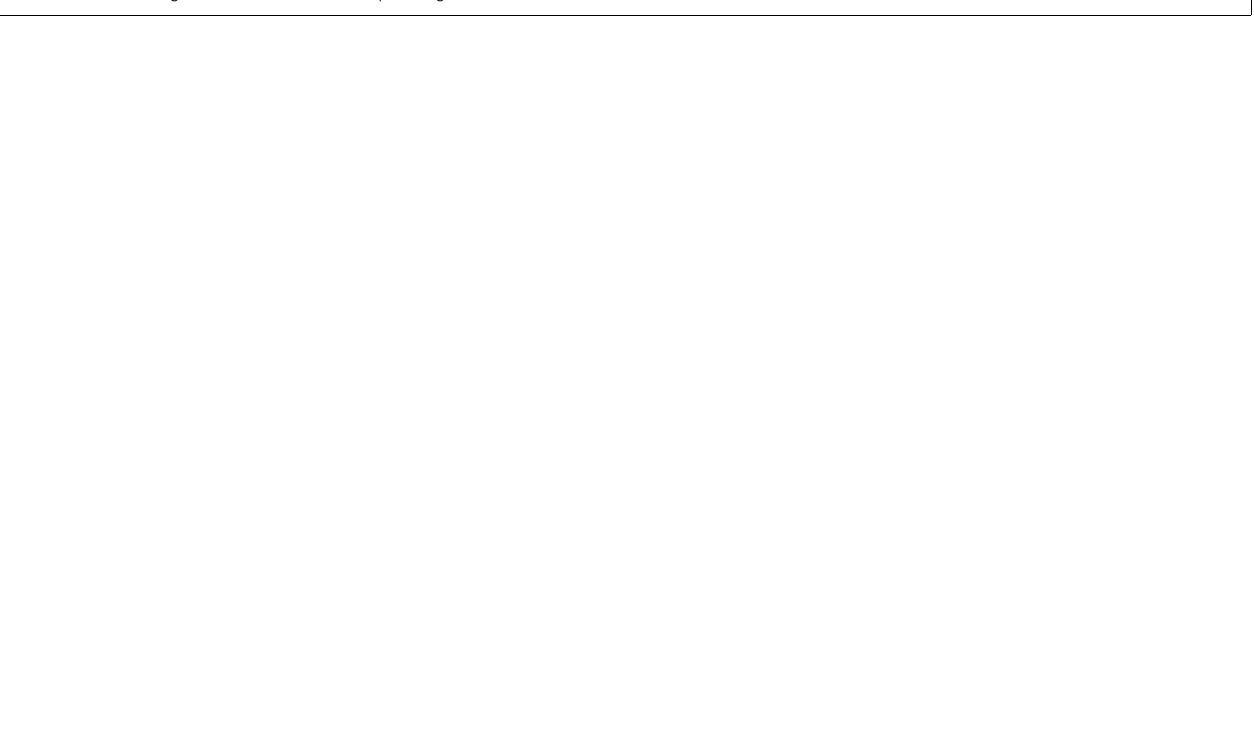
spectroscopy (EPR) flat cell (Suprasil) at a rate of 1mL/min.The solution saturated with nitric oxide was continuously irradiated in the EPR cavity by the means of a Xenon illuminator (model LUZ-XE, Luzchem).The EPR spectra were recorded at room temperature on a FA-100 JEOL EPR spectrometer.The experimental setting was as followed: microwave power 1mW, modulation width 0.1mT, sweep time 1min, time constant